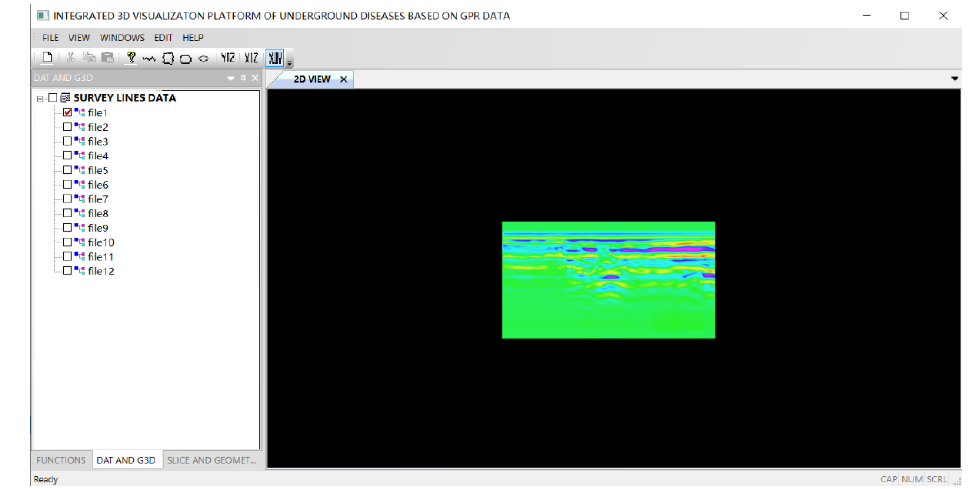
Figure 7. Survey line data visualization.